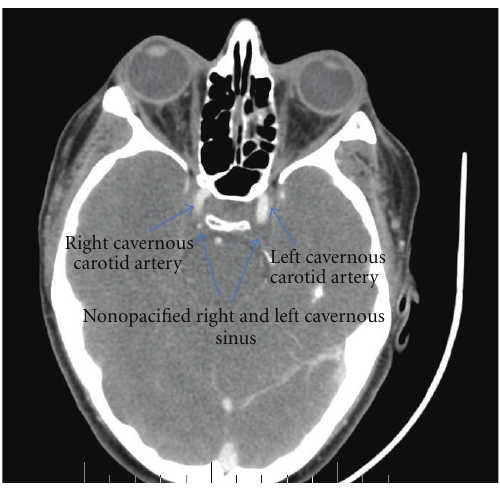
Figure 3: CT scan of the head and neck with contrast demonstrated a thrombus bilaterally into the cavernous sinuses.